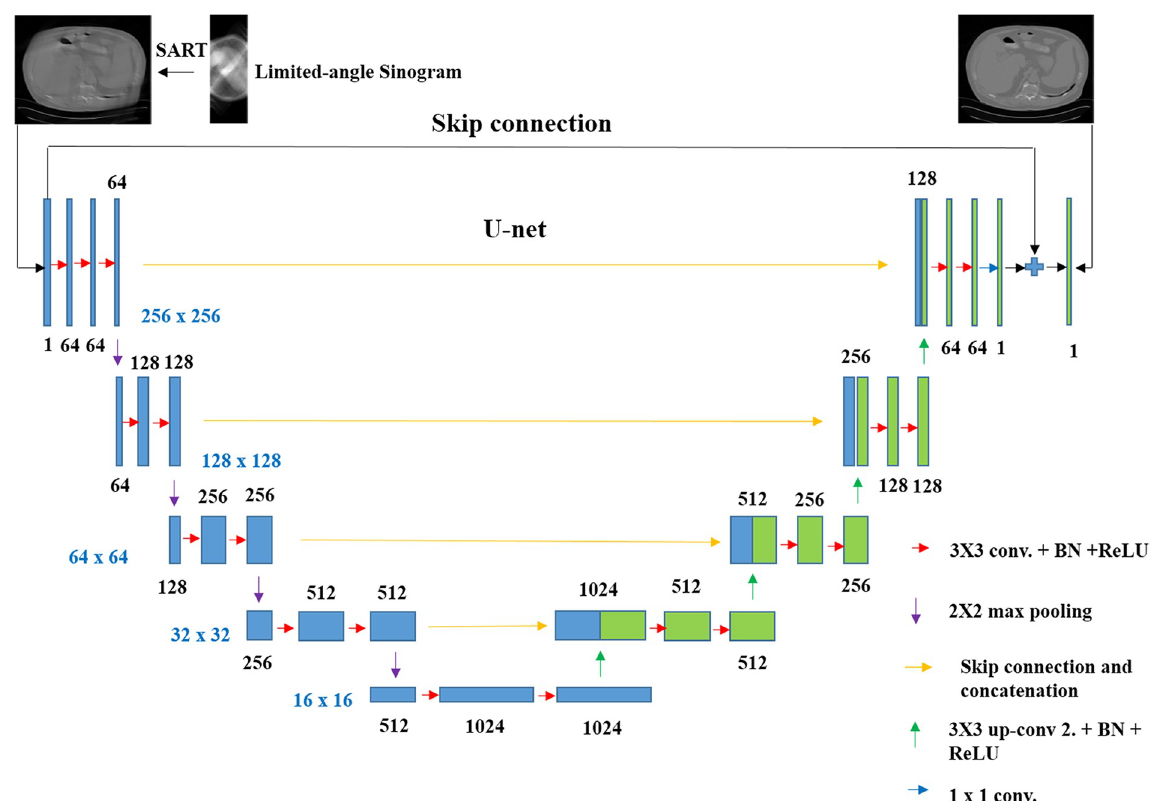
Fig 5. Architecture of SARTConvNet.